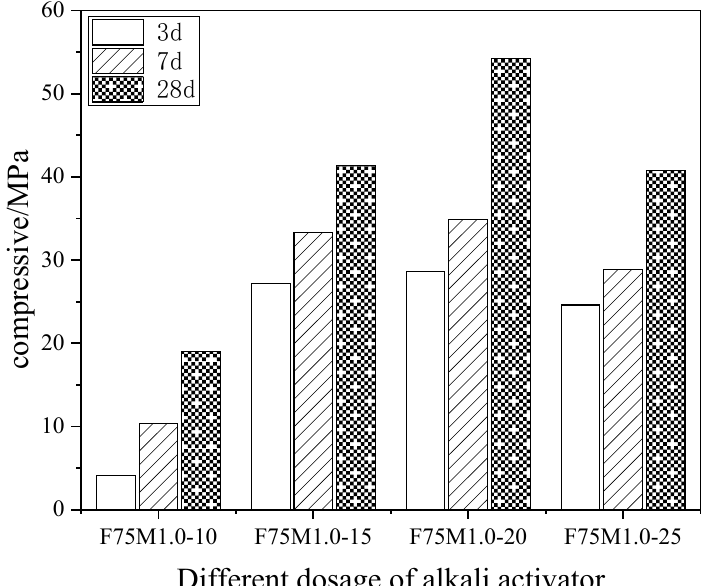
Figure 2. The effects of different alkali activators content on the compressive strength of the geopol- ymer.